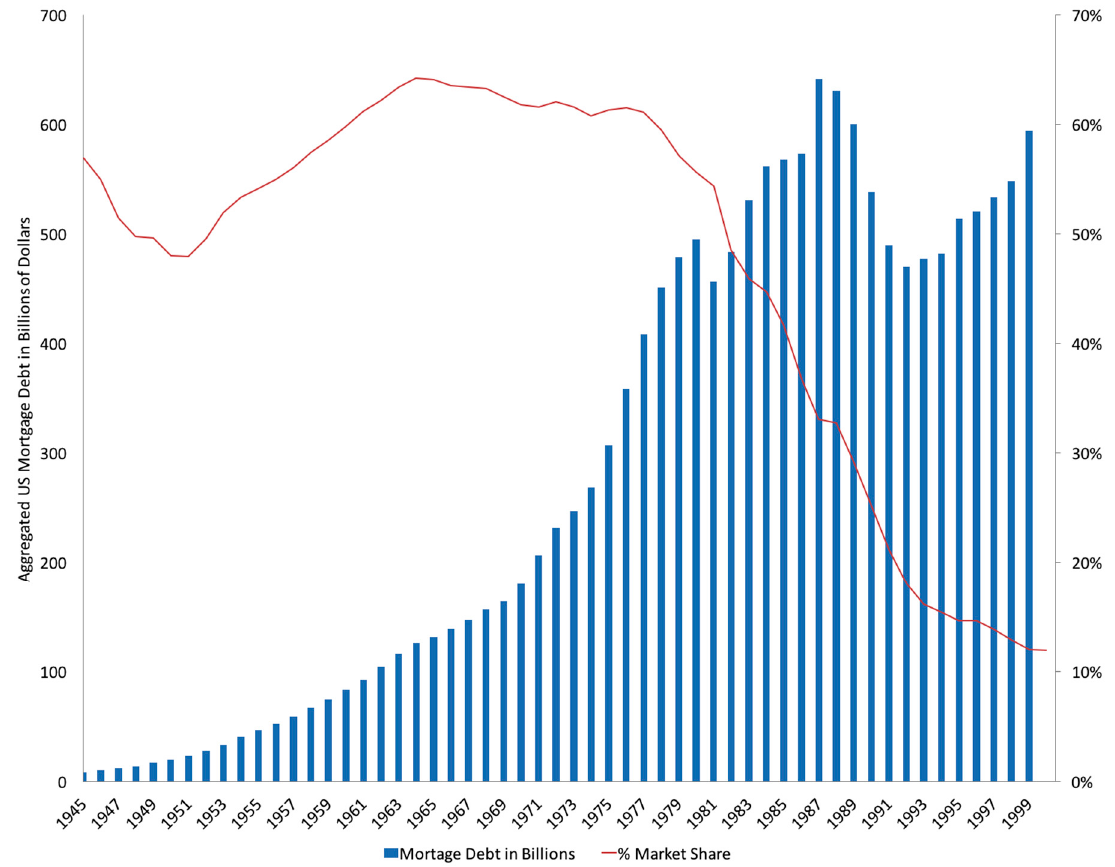
Figure 2. Changes in “Thrift Market Share”, which uses data from the Federal Reserve Board, Flow of Funds Accounts: Annual Flows and Outstanding’s.